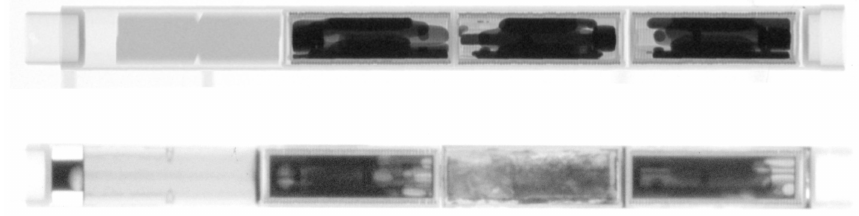
Figure 14. Test rod with steel encapsulating Hg samples before ( top ) and after ( bottom ) long-term exposure inside the SINQ target; the capsule in the middle has broken and Hg is leaking inside a separate enclosure, “creeping” into the corners due to the high wetting after irradiation; contact to the Zircaloy tube was successfully avoided in the other two probes.